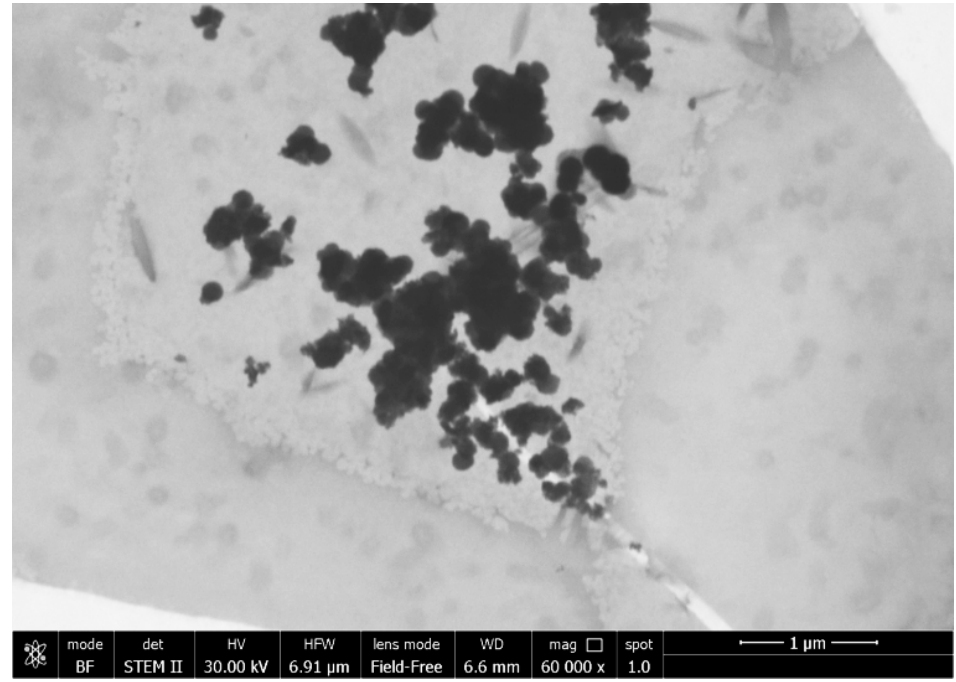
Figure 2 . FESEM micrograph of TiO 2 NPs with C 12 H 28 O 4 Ti:CO(NH 2 ) 2 :NH 4 Cl at a ratio of 2:1:0.52, at 50 °C. Table 8. Dimensions of TiO 2 NPs calculated with FESEM and XRD analyses.